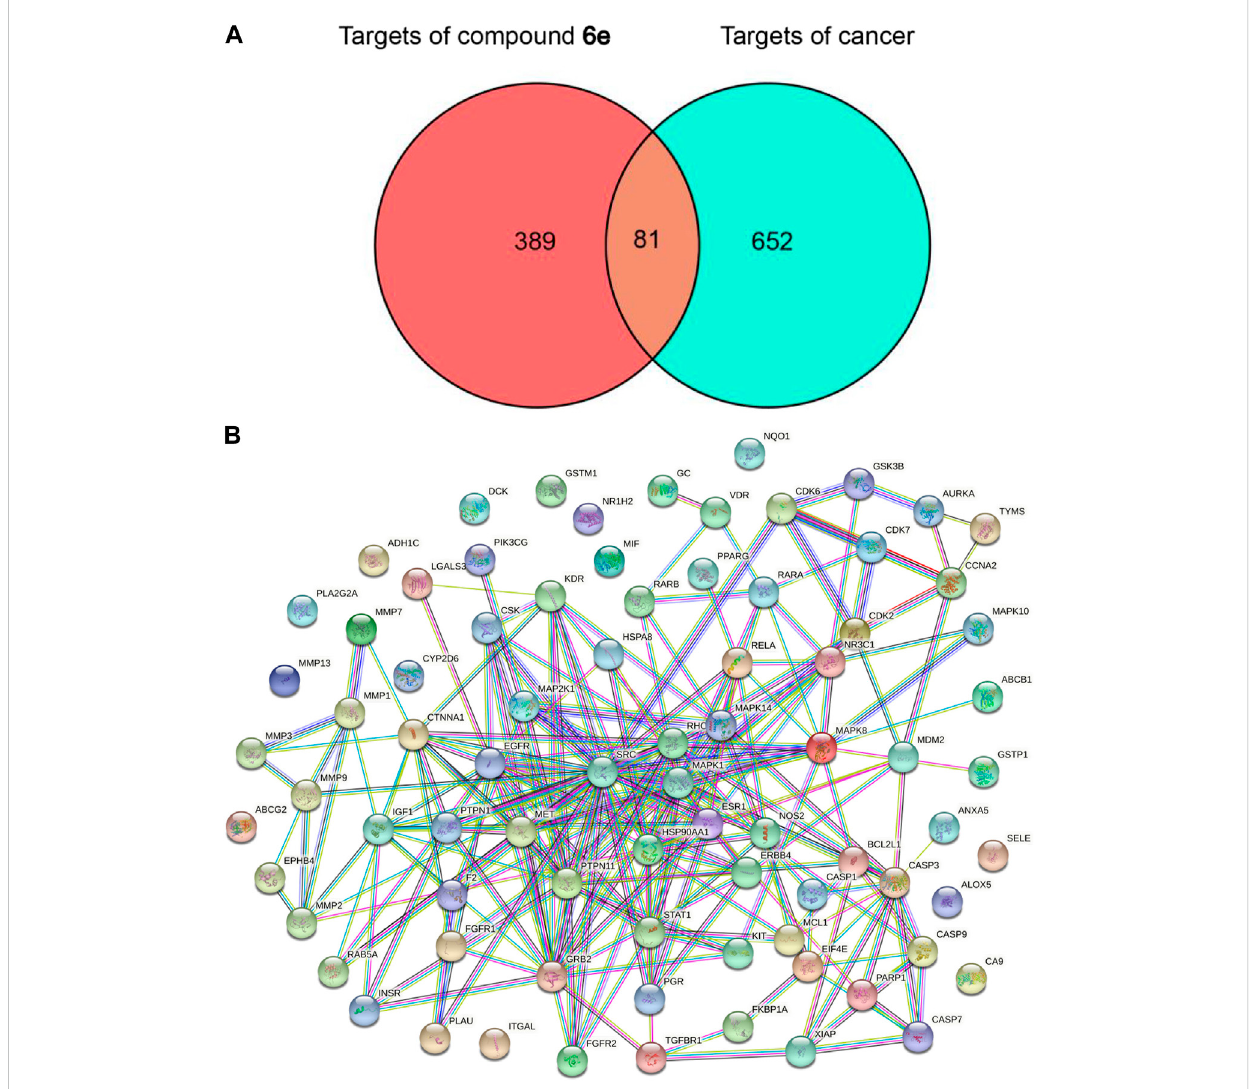
FIGURE 6 Network construction and PPI network core screening. (A) Venn diagram of intersection targets of compound 6e and four types of cancer. (B) PPI network of the overlapping targets of predicted compound 6e targets and cancer targets obtained from Venn